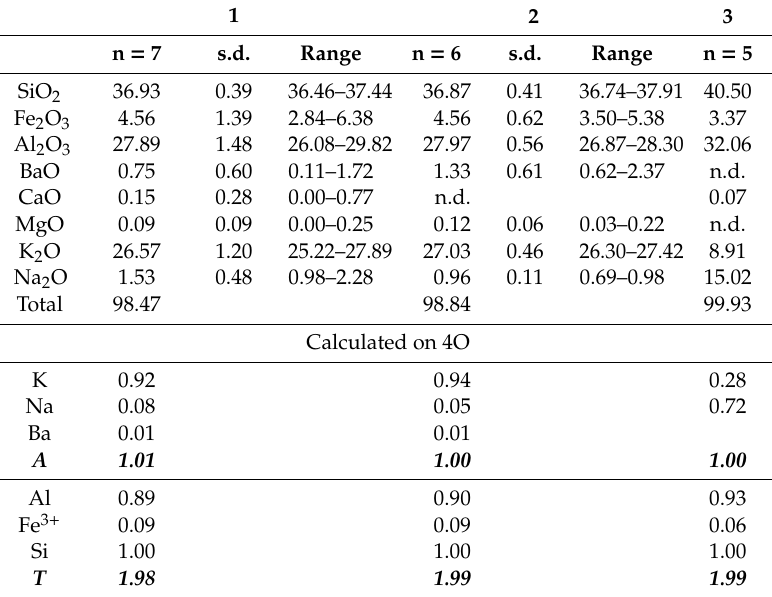
Table 9. Chemical composition of kalsilite from Zuk Tamrur (1) and Gurim Anticline (2) and nepheline from Gurim Anticline (3).